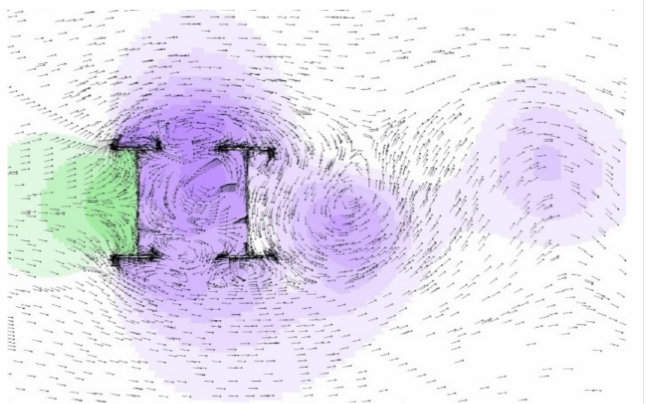
Figure 10. Pressure field for a simulation with two beams. Purple low-pressure zones and green represent high-pressure zones.